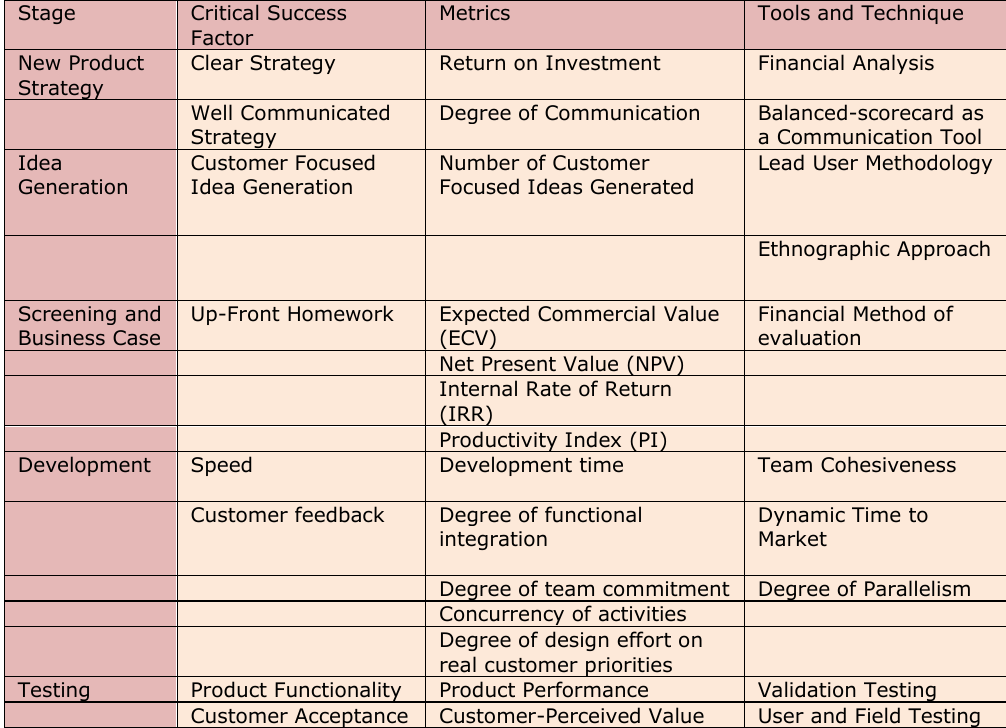
Table 1. Critical Success Factors and Metrics for Stages of NPD